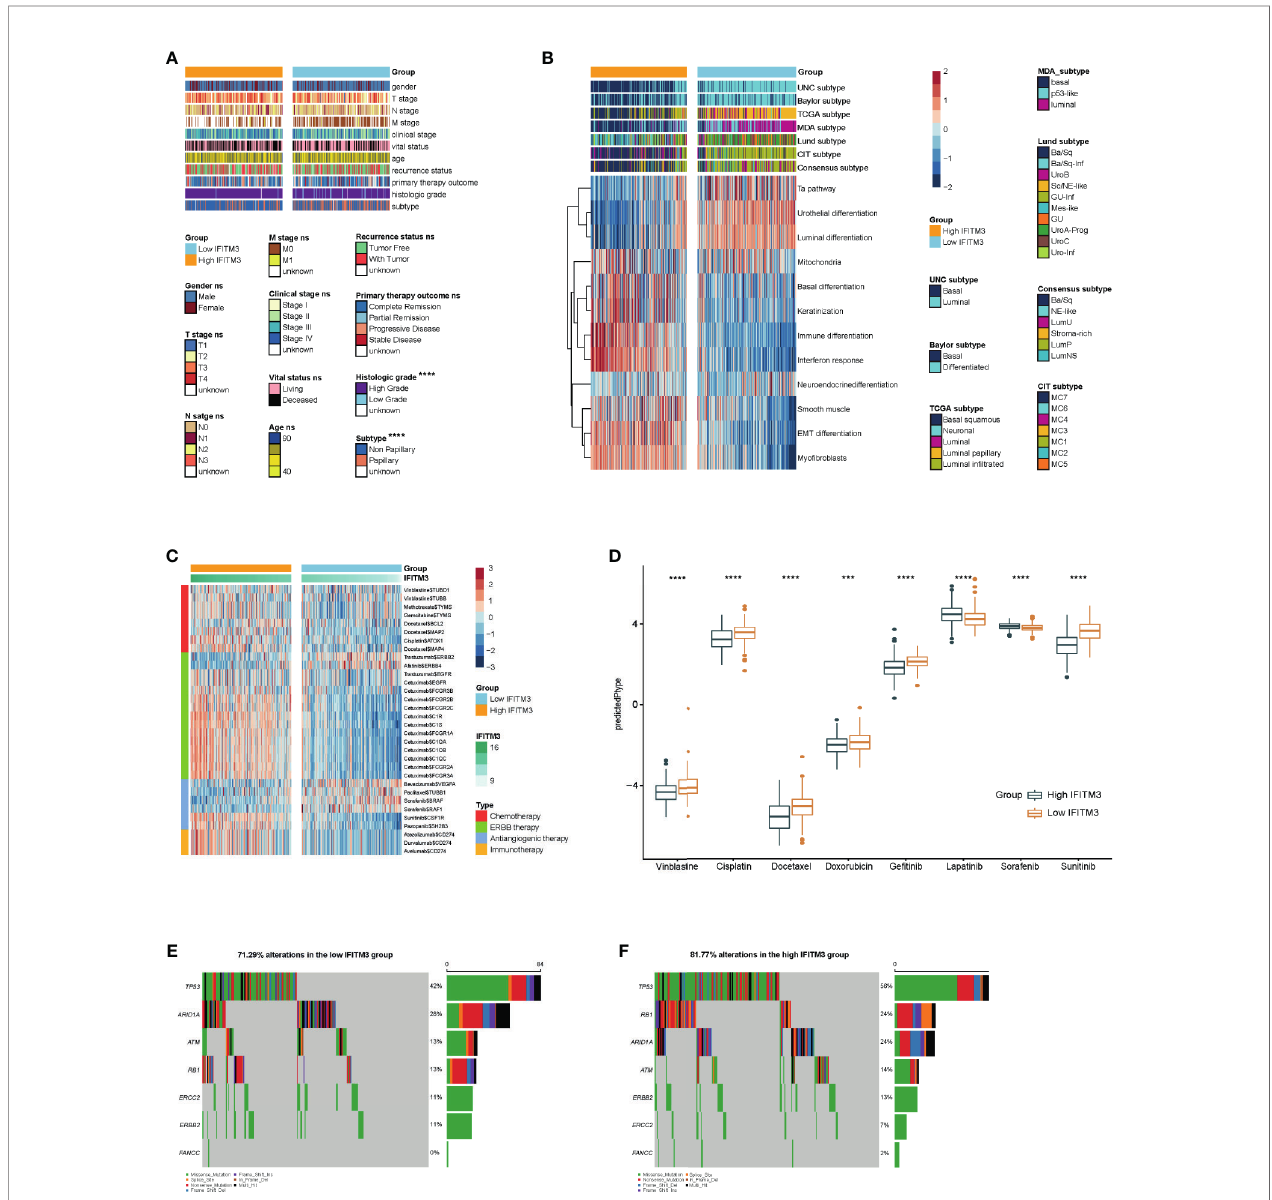
FIGURE 4 | IFITM3 predicts the molecular subtype and response to therapeutic options in BLCA. (A) Correlations between IFITM3 and clinicopathological features in BLCA. (B) Correlations between IFITM3 and molecular subtypes using seven different algorithms (CIT, Lund, MDA, TCGA, Baylor, UNC, and consensus) and BLCA signatures. (C) Correlation between IFITM3 and the drug-target genes extracted from the DrugBank database. (D) Differences in the IC 50 of common anticancer drugs calculated using the “ pRRophetic ” R package between the high- and low-IFITM3 groups. (E, F) Mutational pro fi les of chemotherapy-related genes in the high- and low-IFITM3 groups in the TCGA cohort. *p-value ≤ 0.05, **p-value ≤ 0.01, ***p-value ≤ 0.001, and ****p-value ≤